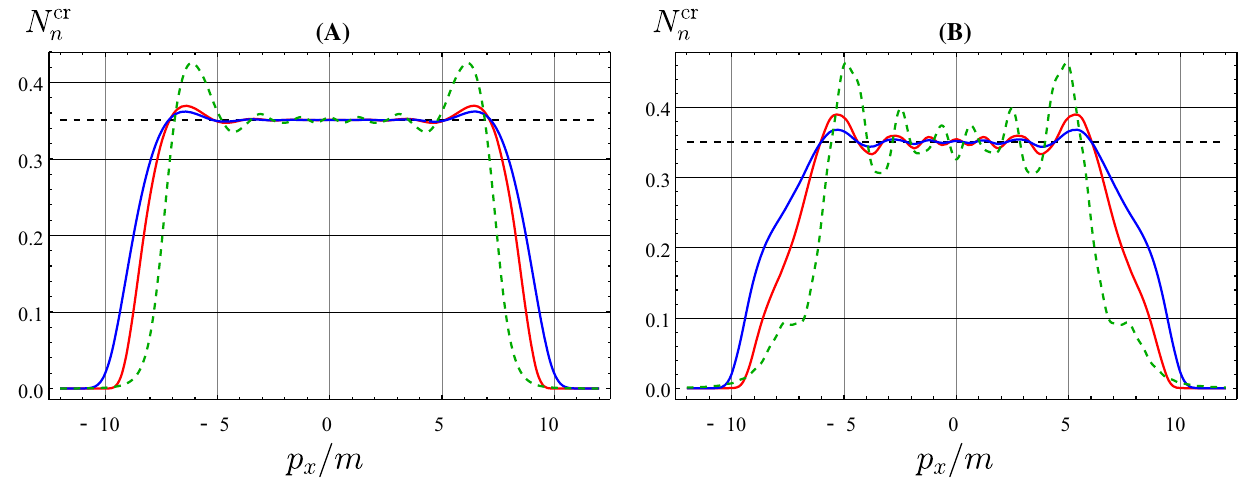
Fig. 8 Differential mean number of Fermions ( a ) and Bosons ( b ) created from the vacuum by electric fields. The solid red and blue lines refers to the composite fields (51) and (62), respectively, with τ = τ = τ and k = k = k . The dashed green lines refers to 1 2 1 2